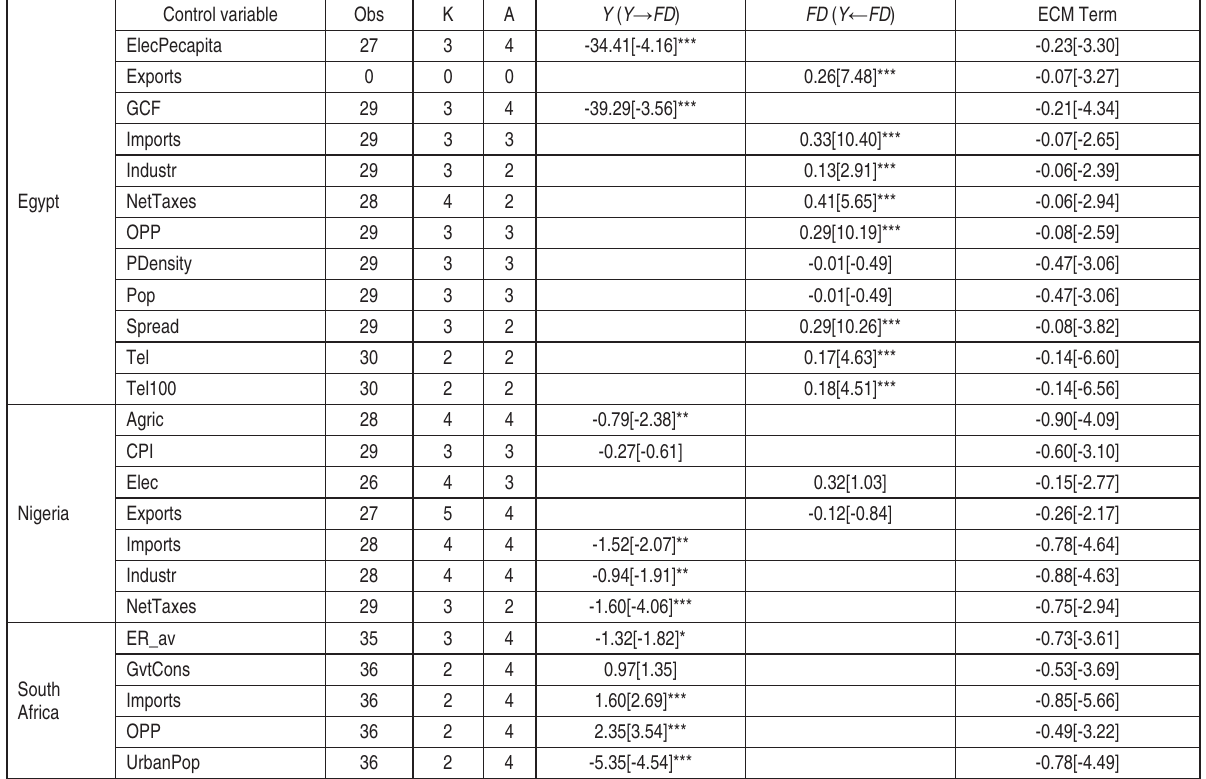
Table 3. Long run parameters: S-Size and per capita